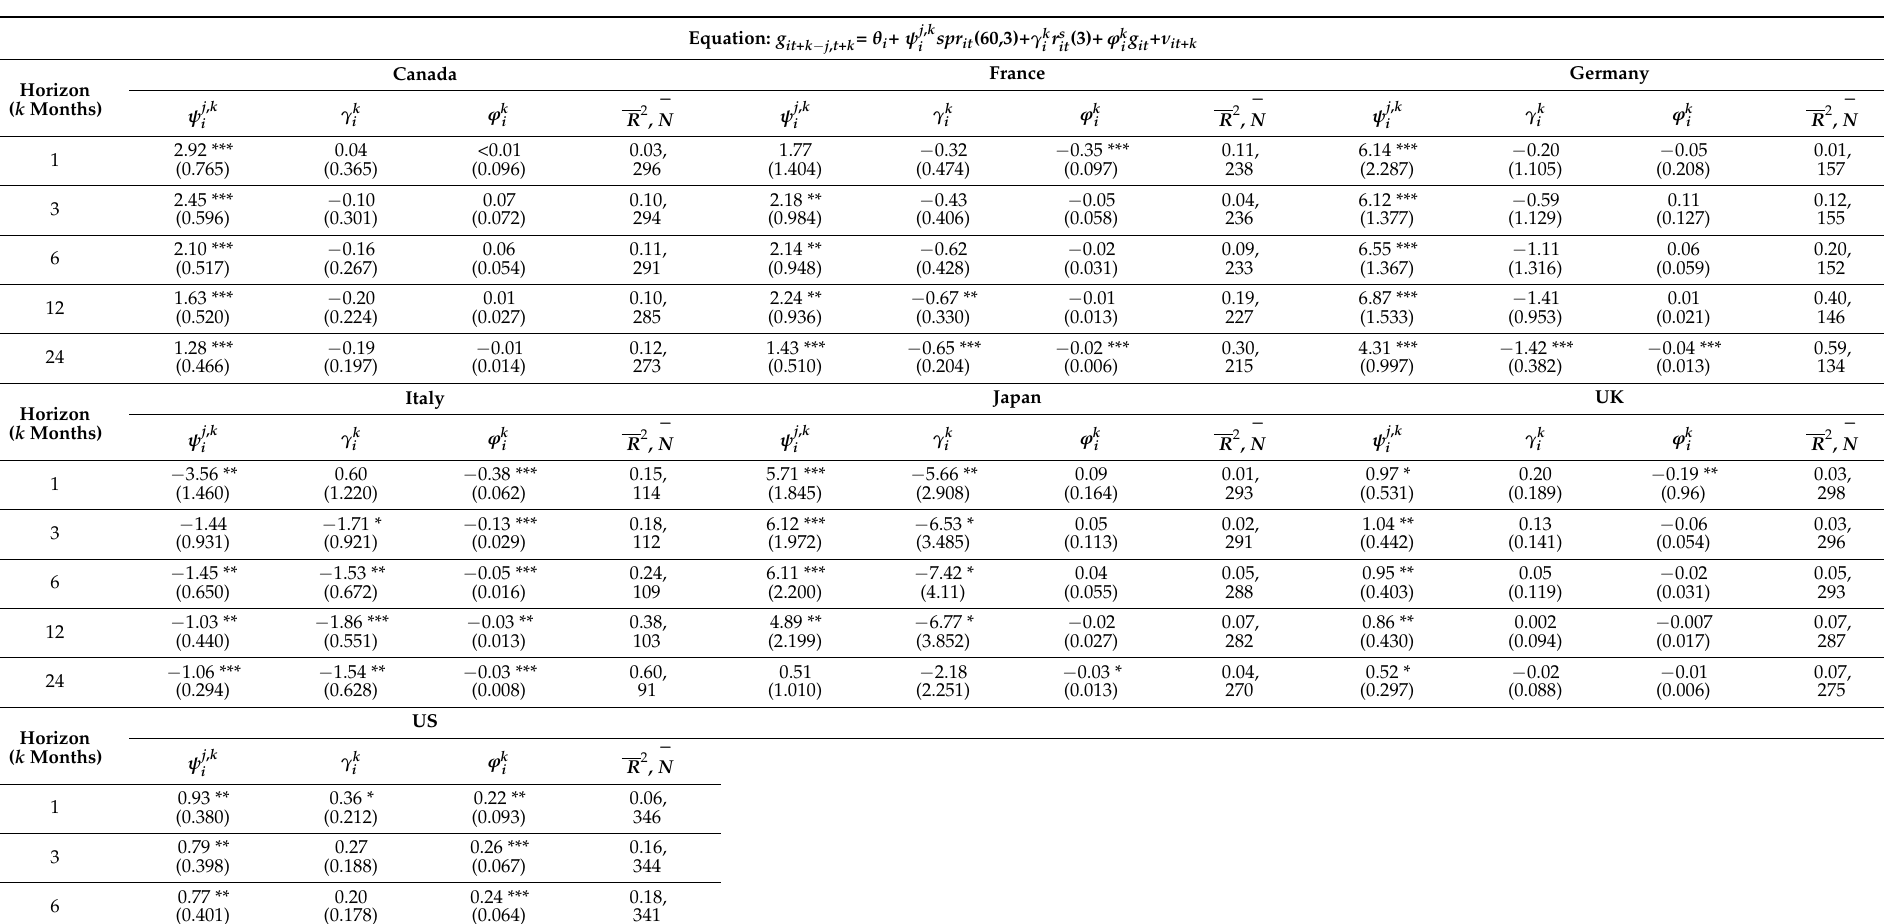
Table A3. Economic activity from the term spread, short rate, and growth rate—cumulative